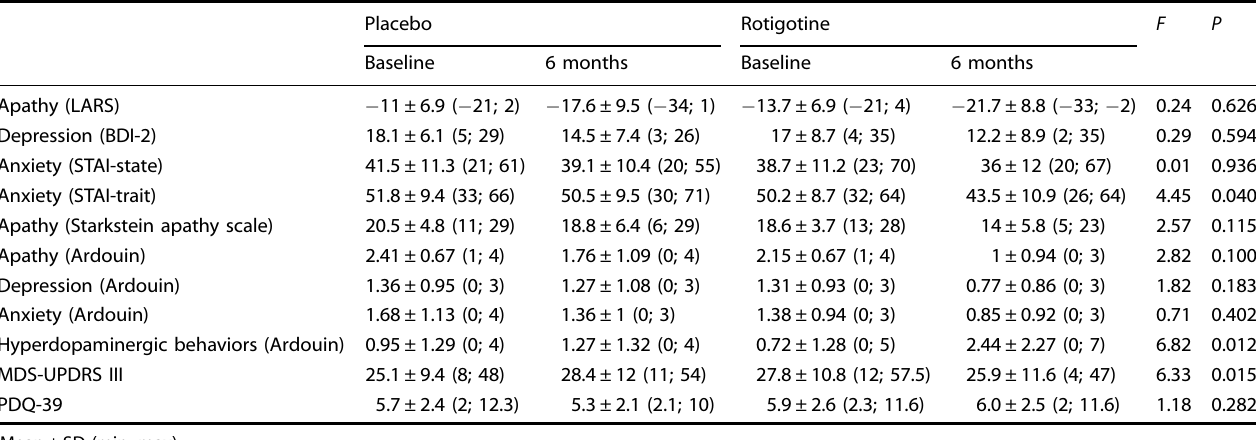
Table 3. Neuropsychiatric, motor and quality of life scores at baseline and at 6 months. Placebo